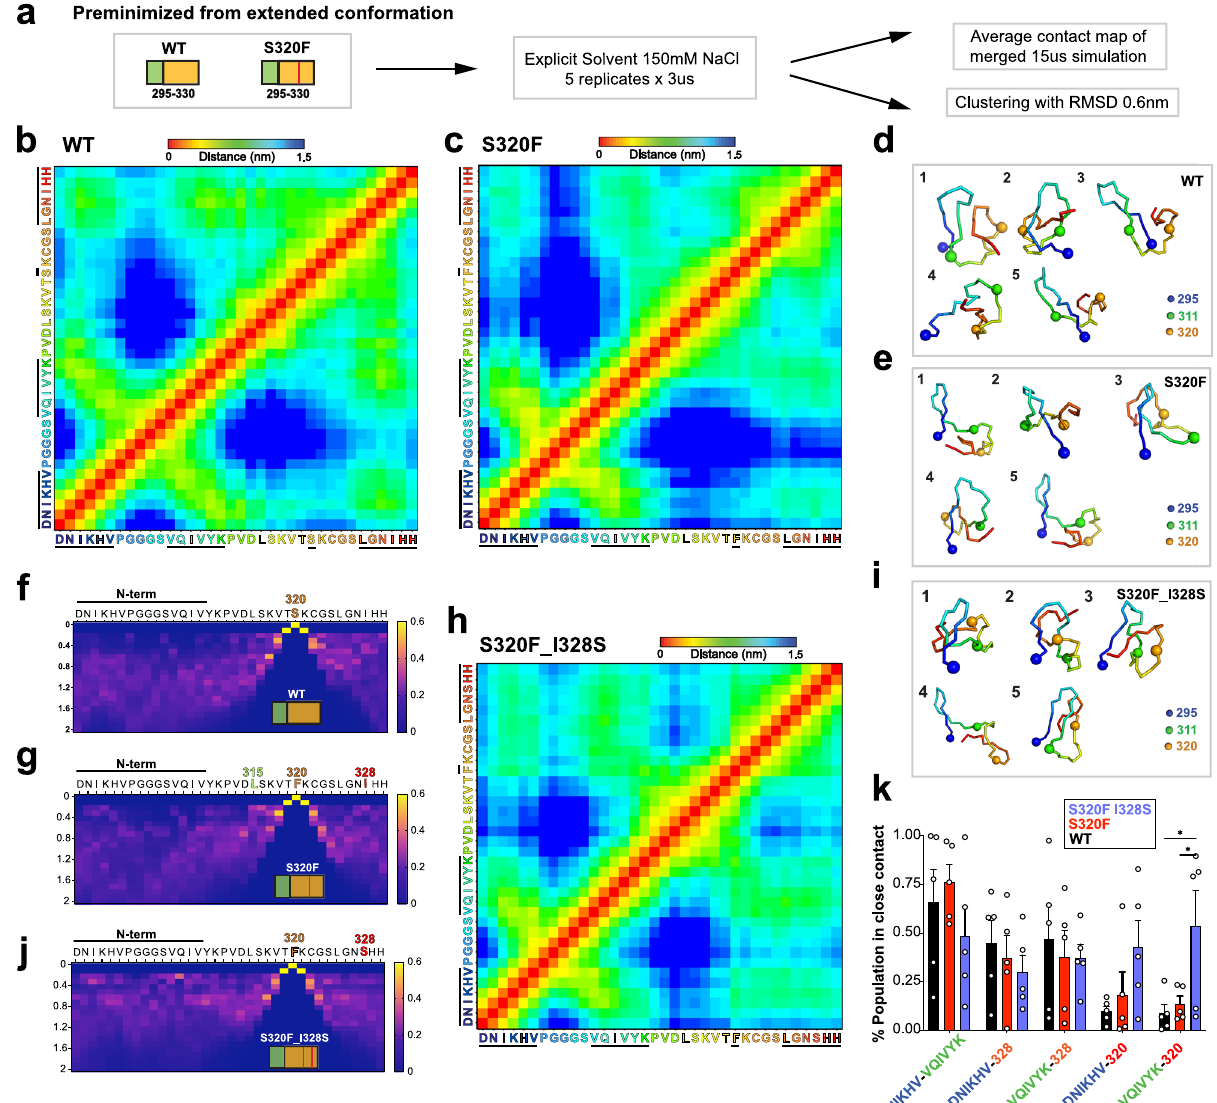
Fig. 3 | MD simulations reveal different conformations for WT and S320F 295- 330 fragments and implicate I328 to be involved in the aggregation mechan- ismofS320F.a Simpli fi edschematic of the MD simulation procedure. Averageof fi ve replicate simulations from independent trajectories of 3 µ s is shown in a contact map for b WT 295-330 , and c S320F 295-330 . The color bar of the contact map indicatesthedistancebetweenpairsofresiduesintherangeof0 – 1.5nm.Themean structure of each of the top fi ve clusters within 0.6nm RMSD for simulations of d WT 295-330 , and e S320F 295-330 . Positions 295, 311 and 320 are shown in blue-, green- and orange-colored spheres. Sequences are colored with the rainbow spectrum and match the residue coloring in b and c . C α distance distribution of